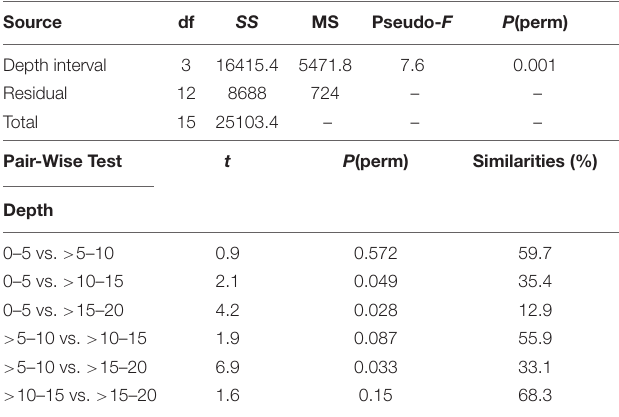
TABLE 3 | PERMANOVA partitioning and analysis of prey item per depth intervals (4) from Yerbas Buenas Bay, based Bray–Curtis dissimilarities.